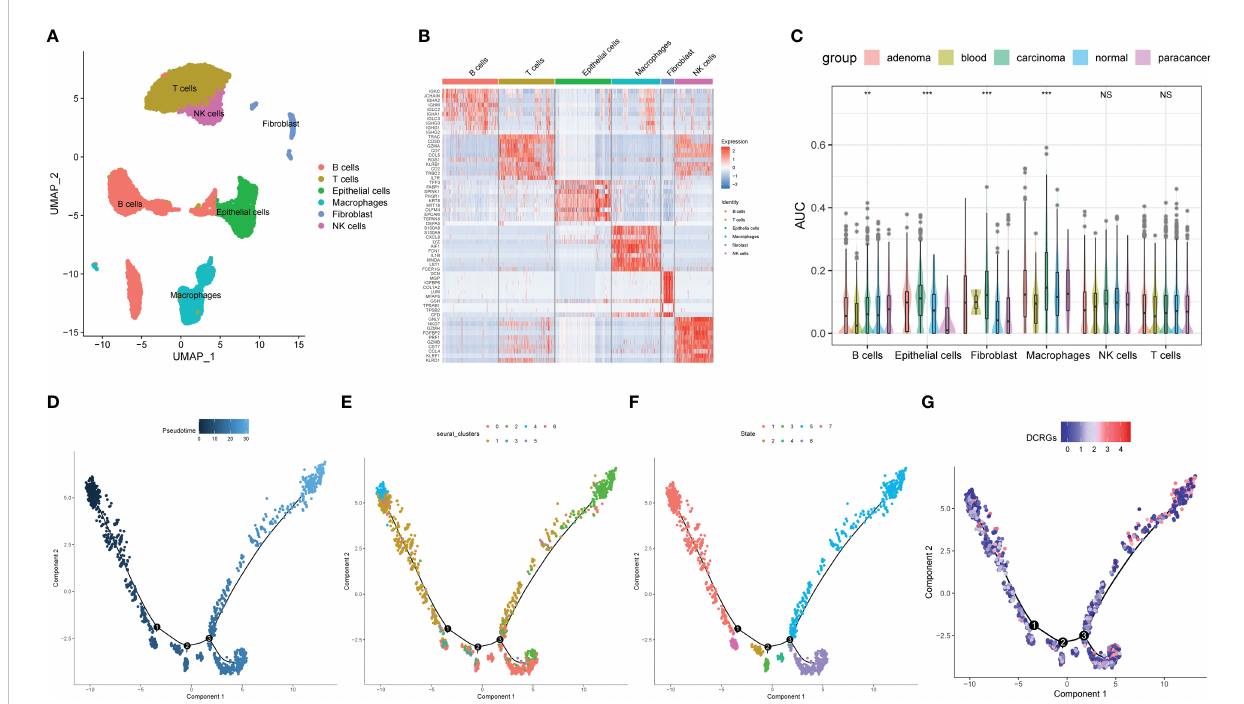
FIGURE 6 Analysis of single-cell RNA sequencing of COAD. (A) UMAP plot of the cell clusters of GSE161277. (B) Top 10 marker genes among the eight cell clusters. (C) AUC scores of the DCRGs among each cell type. (D) The cell differentiation timeline, where deeper colors represent earlier developmental stages. (E) The distribution of different clusters of macrophages in the cell trajectory curve. (F) The distribution of different states of macrophages on the cell trajectory curve. (G) Distribution of the average expression of DCRGs on the cell trajectory curve. ** P < 0.01,*** P <